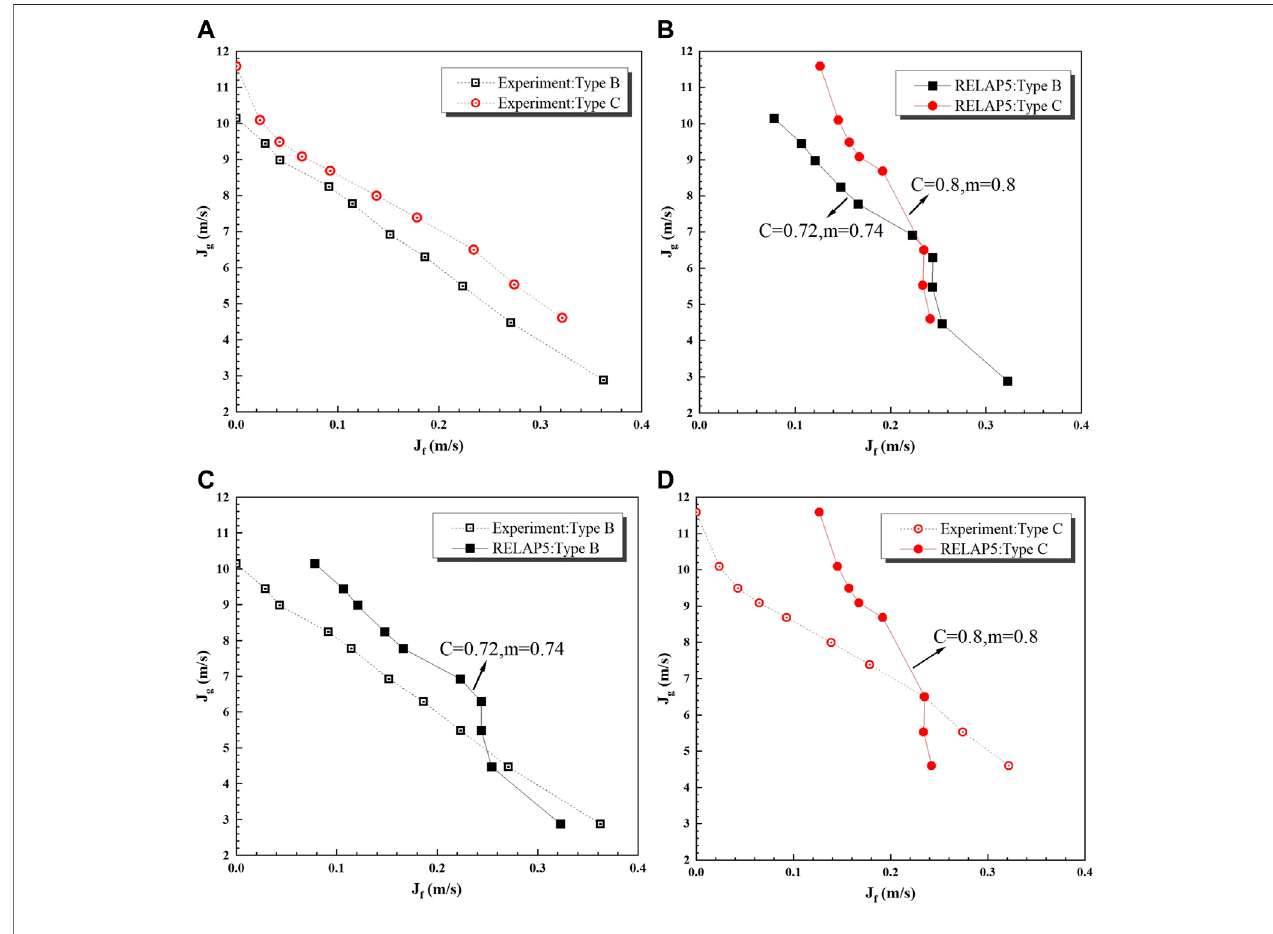
FIGURE 12 | Effect of inclined pipe upper exit